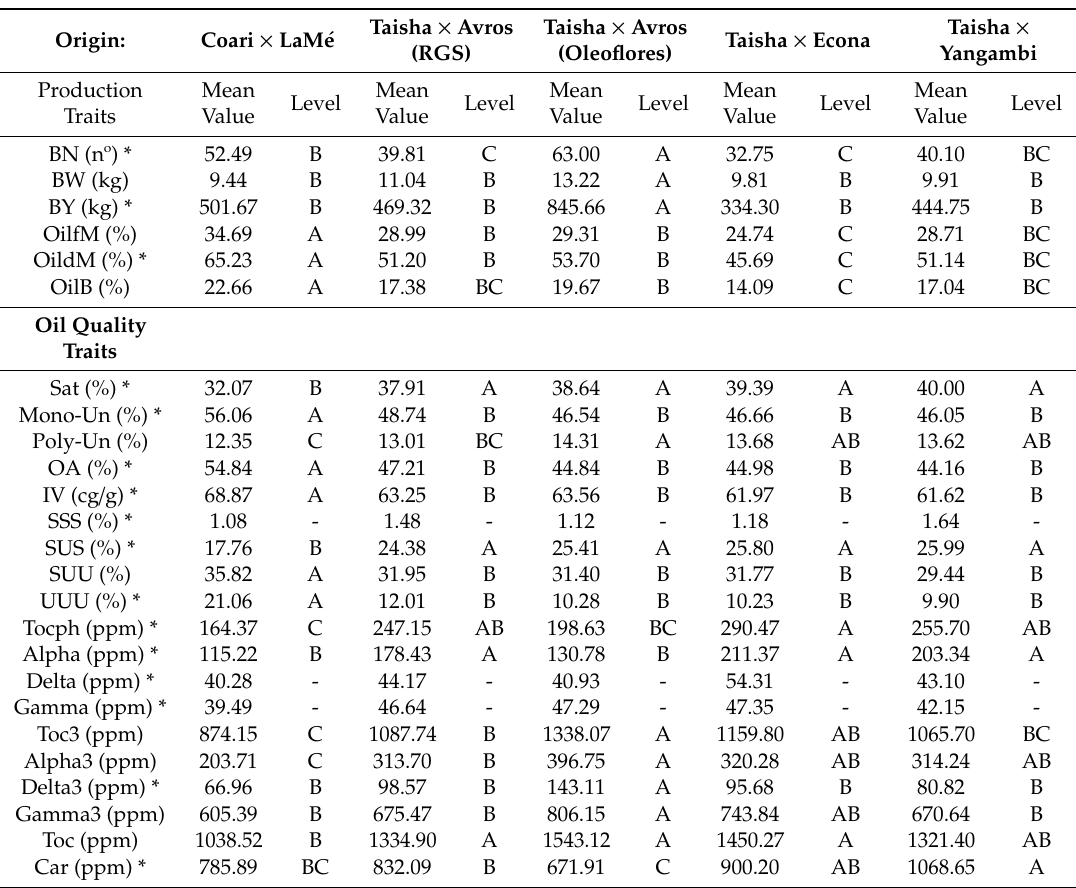
Table 1. Mean values of the studied traits for each origin and significant levels obtained by Tukey post hoc